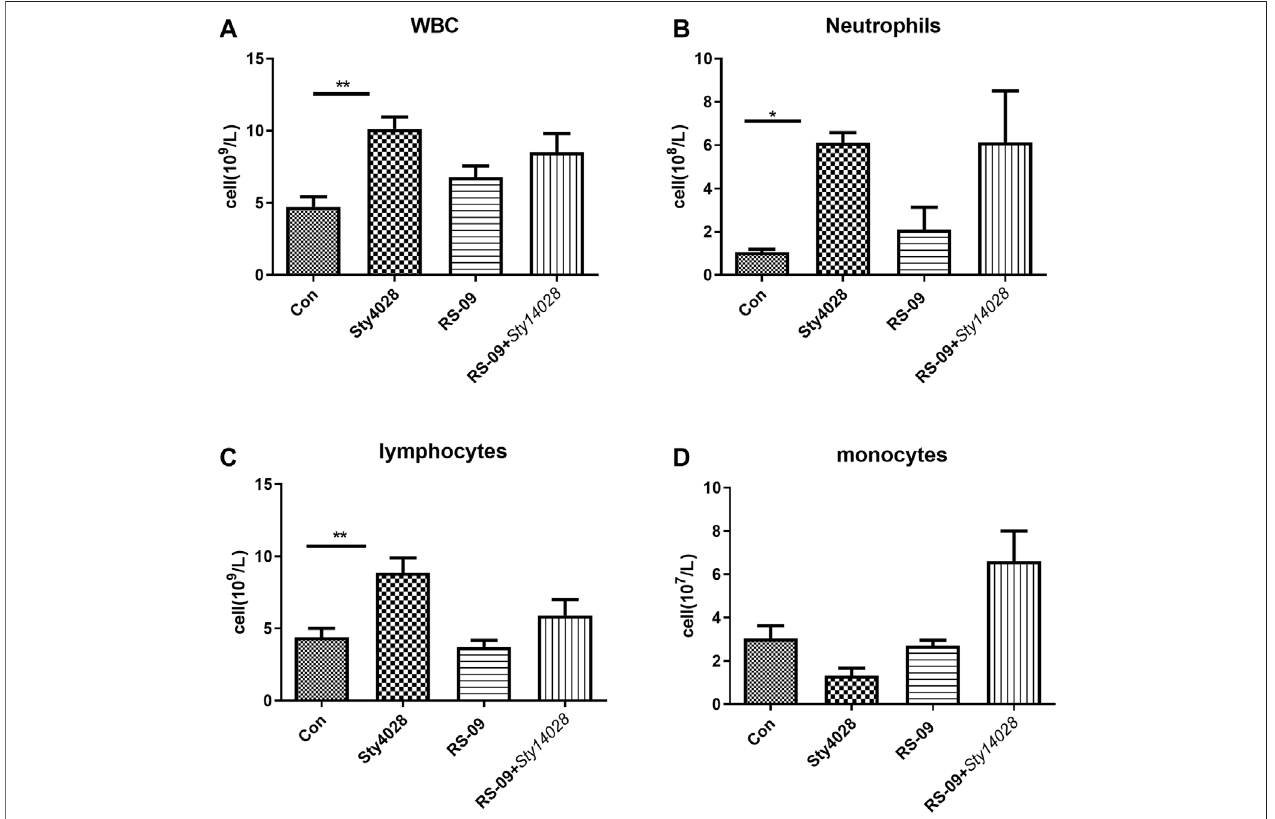
FIGURE 4 | Haematological analysis of mice following an intragastric challenge with S . Typhimurium. The total numbers of WBCs (A) , as well as the levels of circulating neutrophils (B) , lymphocytes (C) , and monocytes (D) , were evaluated in different groups. Data are the means ± SD ( n = 3). * p < 0.05; ** p < 0.01.